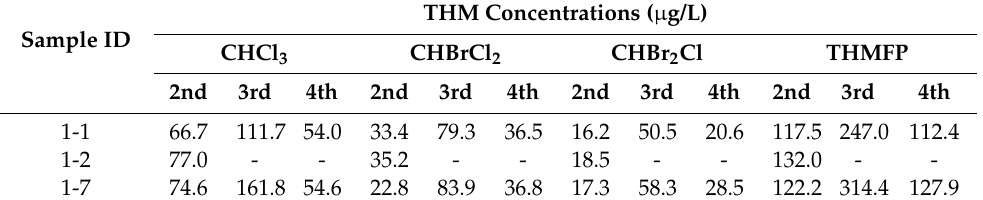
Table 3. Trihalomethane (THM) formation potential and major THM species in the selected samples from System